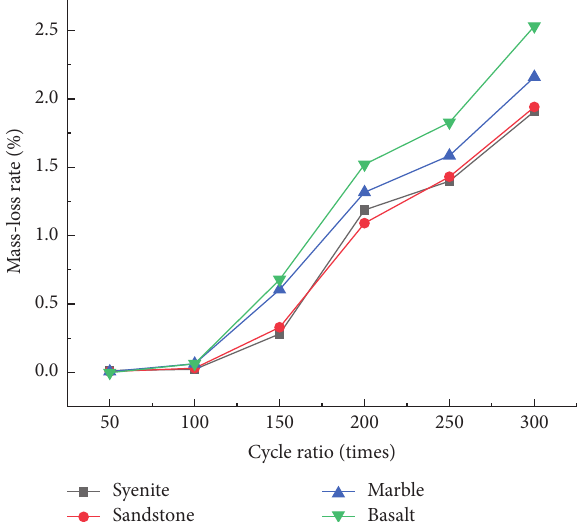
Figure 8: Fatigue test results. Figure 6: Mass-loss rate of concrete freeze-thaw